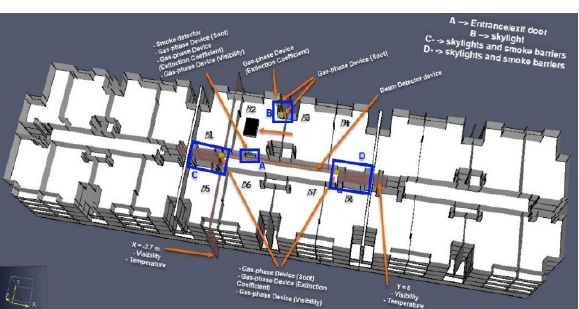
Figure 6. Scenario No.6: The generated model in PyroSim with layers, sensors, and burning object in unit B2 Figure 8. Smoke emission status on various floors at seconds: (A) 10 and hrr=6.7 kW ; (B) 75 and hrr=10.1 kW ; (C) 170 and hrr= 4.8 kW ; (D) 250 and hrr =2.4 kW ; (E) 400 and hrr=2.4 kW ; (F) 550 and hrr=2.4 kW ; (G) 700 and hrr=2.4 kW ; (H) 800 and hrr=2.4 kW .